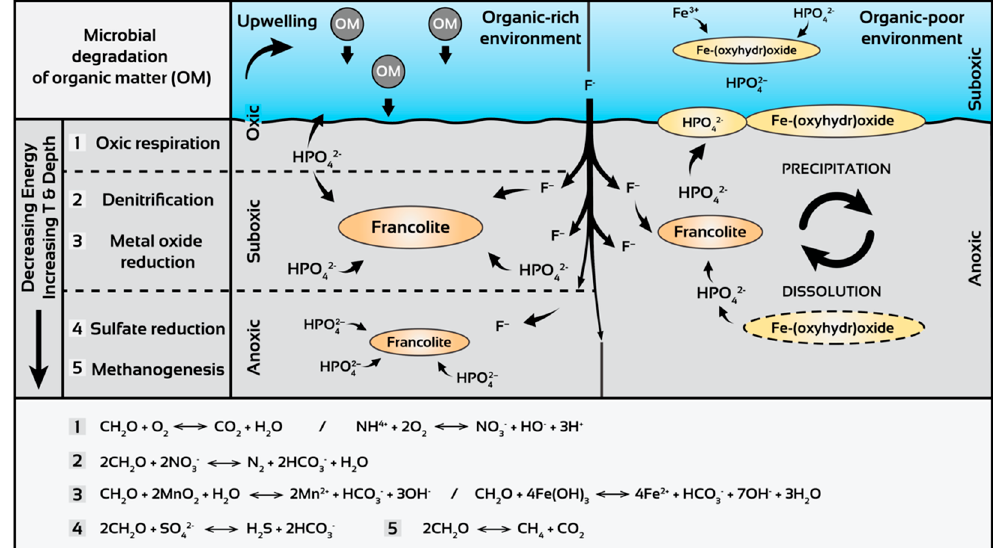
Figure 1. Different phosphogenic processes. In upwelling environments, organic matter (OM) is microbially degraded through a series of chemical reactions that lead to the concentration of dissolved phosphate in pore water, facilitating the authigenic precipitation of carbonate fluorapatite. In organic-poor environments, Fe redox pumping is the primary process leading to high concentrations of phosphate in pore water via cyclical adsorption and release of phosphate from Fe oxyhydroxides. (Modified from Pufahl and Groat (2017), and references therein [2]).